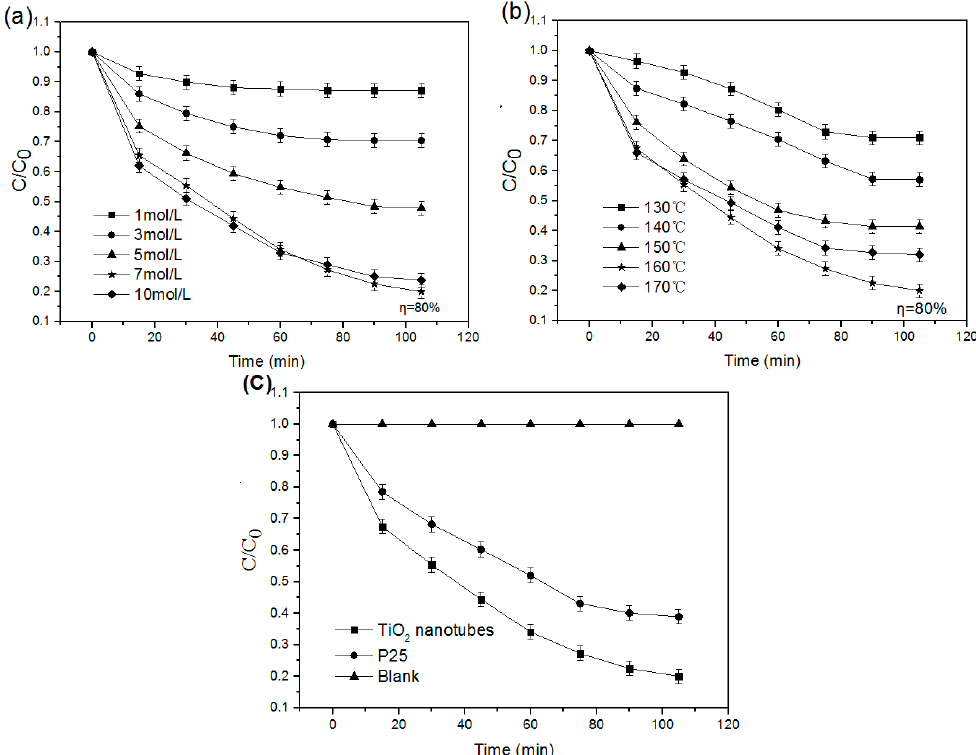
Figure 9. Variation of C/C 0 of MO (20 mg/L) solution with the photocatalytic time.